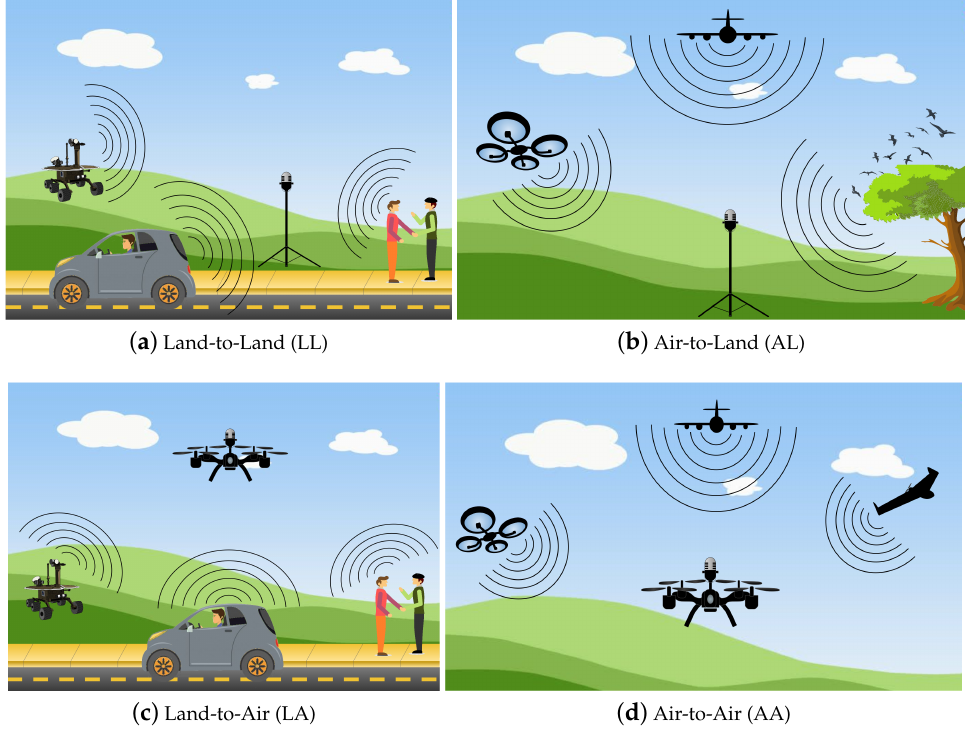
Figure 1. Auditory perception categories defined in this review. The category indicates the origin of the sound and the site where the microphone is placed. Typically, auditory perception has been widely studied for LL. In this review, we focus on auditory perception for unmanned aerial vehicles (UAVs) ( b – d ).